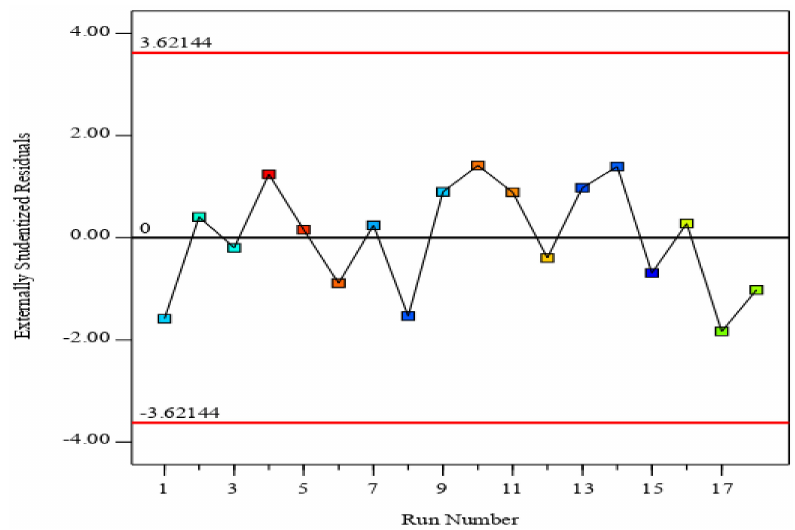
Figure 13. Plot of the externally residuals versus run number of the linear model. The plot of the actual versus predicted values is influential to understand the linear relationship between the actual and the predicted values. Also, the assumption of linearity was checked through a plot of the relationship between the actual and the predicted values.